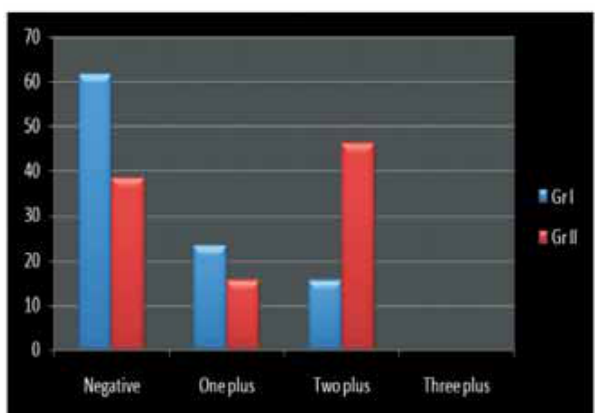
Figure-2: Graph for faecal shedding in percentage at different intervals during the study period. Table-2: Faecal shedding in different groups evaluated by Ziehl Neelsen's staining No. of samples (n) Group Level of shedders No. of positive